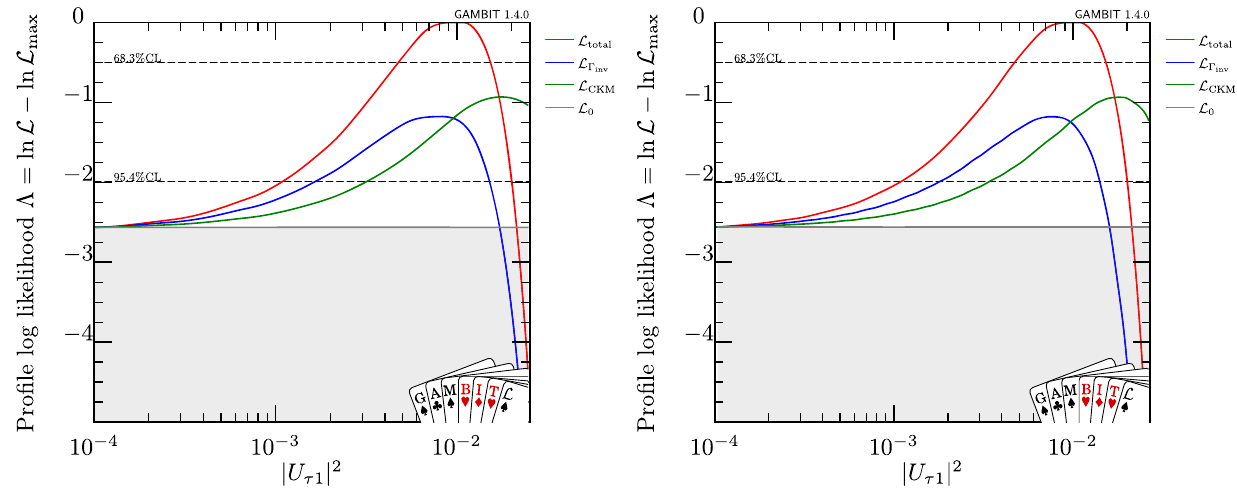
Fig. 15 One-dimensional profile likelihood for U 2 τ , L total , and partial likelihoods for Γ Z , CKM and combination of the rest of constraints, L 0 , in 1 the low mass region, M 1 < 1 GeV, for normal (left) and inverted hierarchy